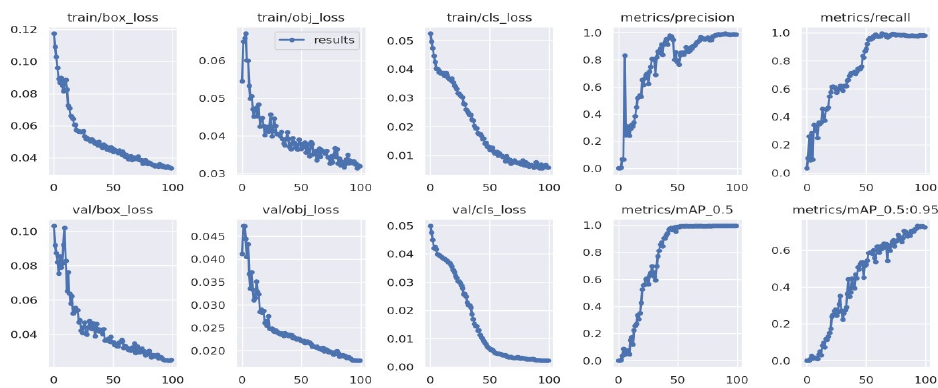
Figure 7. Performance training analysis plot graphs of the CNN network with a large YOLO-V5 model.